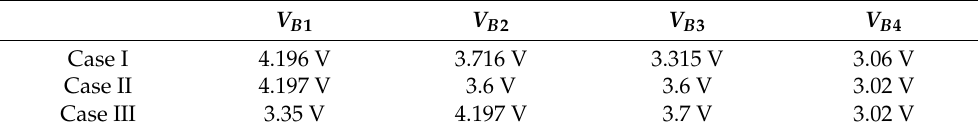
Table 5. Three cases of initial voltage and